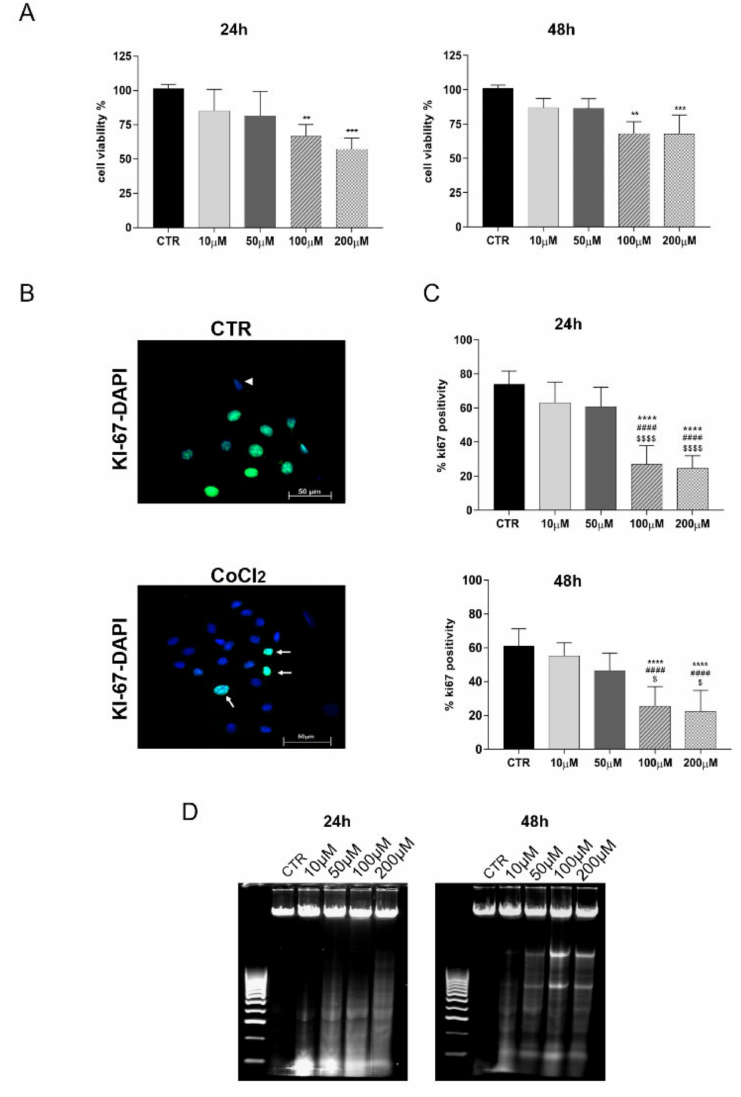
Figure 2. Dose-response assessment of CoCl 2 on oAEC viability and proliferation. For this experiment, cells were treated with 0 (CTR), 10, 50, 100, and 200 µ M of CoCl 2 for 24 and 48 h of incubation. ( A ) The histograms show oAECs’ viability of untreated (CTR) and CoCl 2 -treated cells detected with the MTT assay. Data are expressed as a percentage of vital cells ± SEM obtained from experimental triplicates for each biological sample ( n = 3 different animals). CTR viability was set as 100%. ( B ) Representative IHC images showing the nuclear localization of the proliferation marker KI-67 (green fluorescence) in oAECs cultured for 48 h in the absence (CTR, upper image) or presence of CoCl 2 (lower image). Nuclei were counterstained with DAPI (blue fluorescence). Arrowheads indicate negative stemness nuclear localization in the cells, and arrows indicate positivity. Scale bar: 50 µ m. ( C ) Histograms displaying the incidence of KI-67 positive cells recorded in CTR and CoCl 2 -treated oAECs at 24 and 48 h. The incidence value was expressed as a percentage of KI-67 positive cells/100 total cells ± SEM, obtained from triplicate experiments performed on three different biological samples. Values statistically different for ** p < 0.01, *** p < 0.001, **** p < 0.0001 vs. CTR, #### p < 0.0001 vs. 10 µ M CoCl 2 , and $ p < 0.05 , $$$$ p < 0.0001 vs. 50 µ M. ( D ) Representative agarose gel showing DNA fragmentation